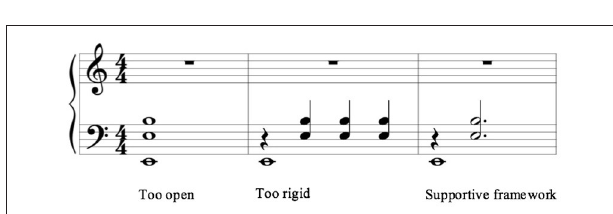
FIGURE 2 | Different options of rhythmic articulation for the bourdon